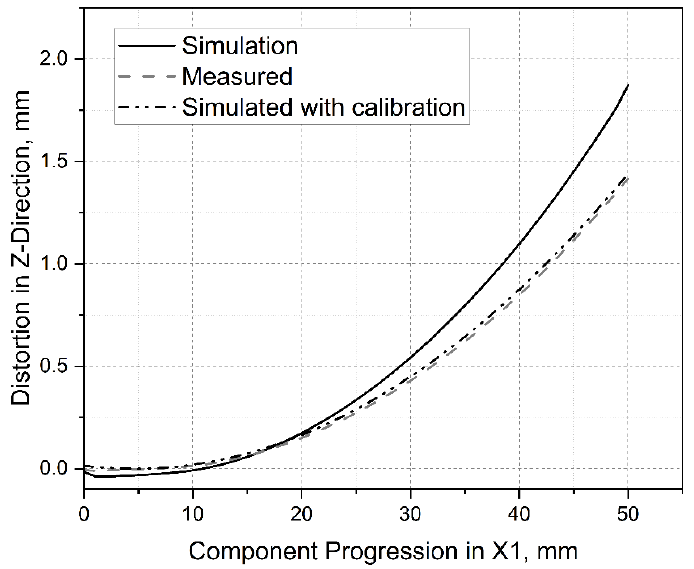
Figure 9. Measured and simulated deformations over the measuring section X1 in the laboratory